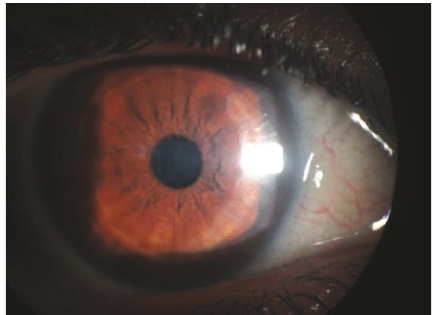
Figure 3: Two weeks after presentation, complete healing of corneal